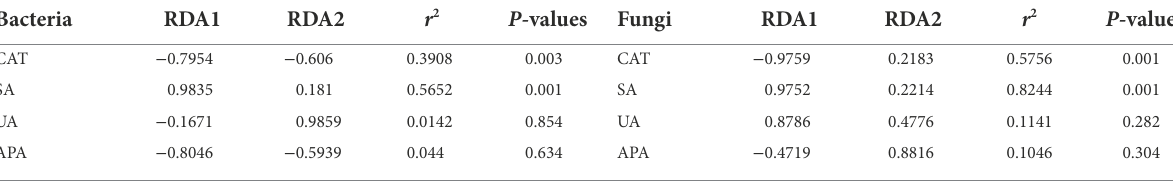
TABLE 5 Monte Carlo permutation test of soil factors on microbial community structure. Bacteria